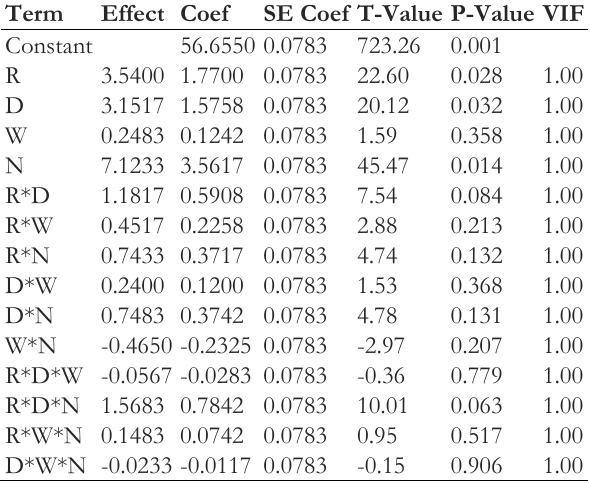
Table 6. Coded coefficient for factorial regression: means versus R, D, W, N.